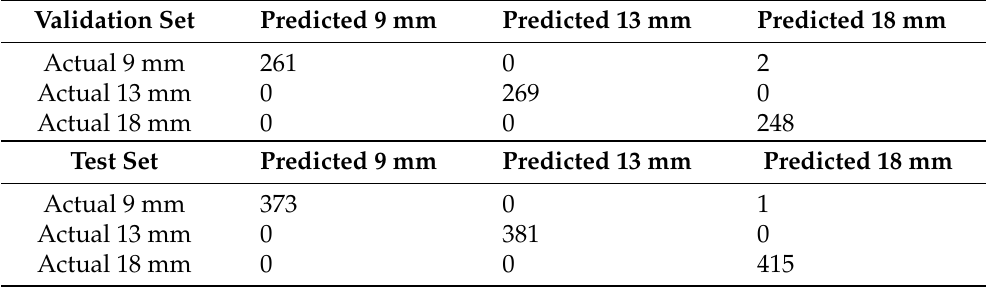
Table 6. Confusion matrix for DED-CNN.